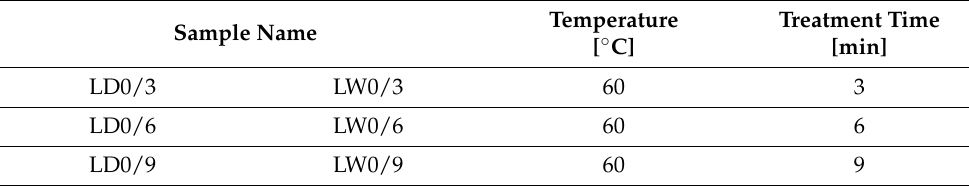
Table 2. Variations of thermal extraction duration for individual